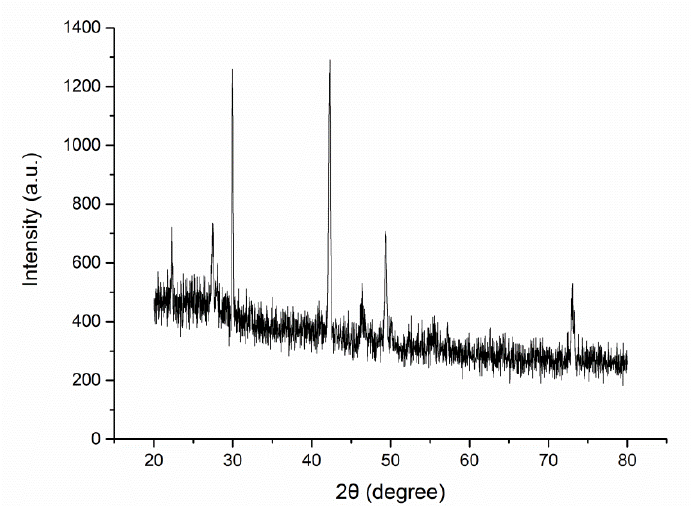
Figure 3. XRD pattern of silver nanoparticles.